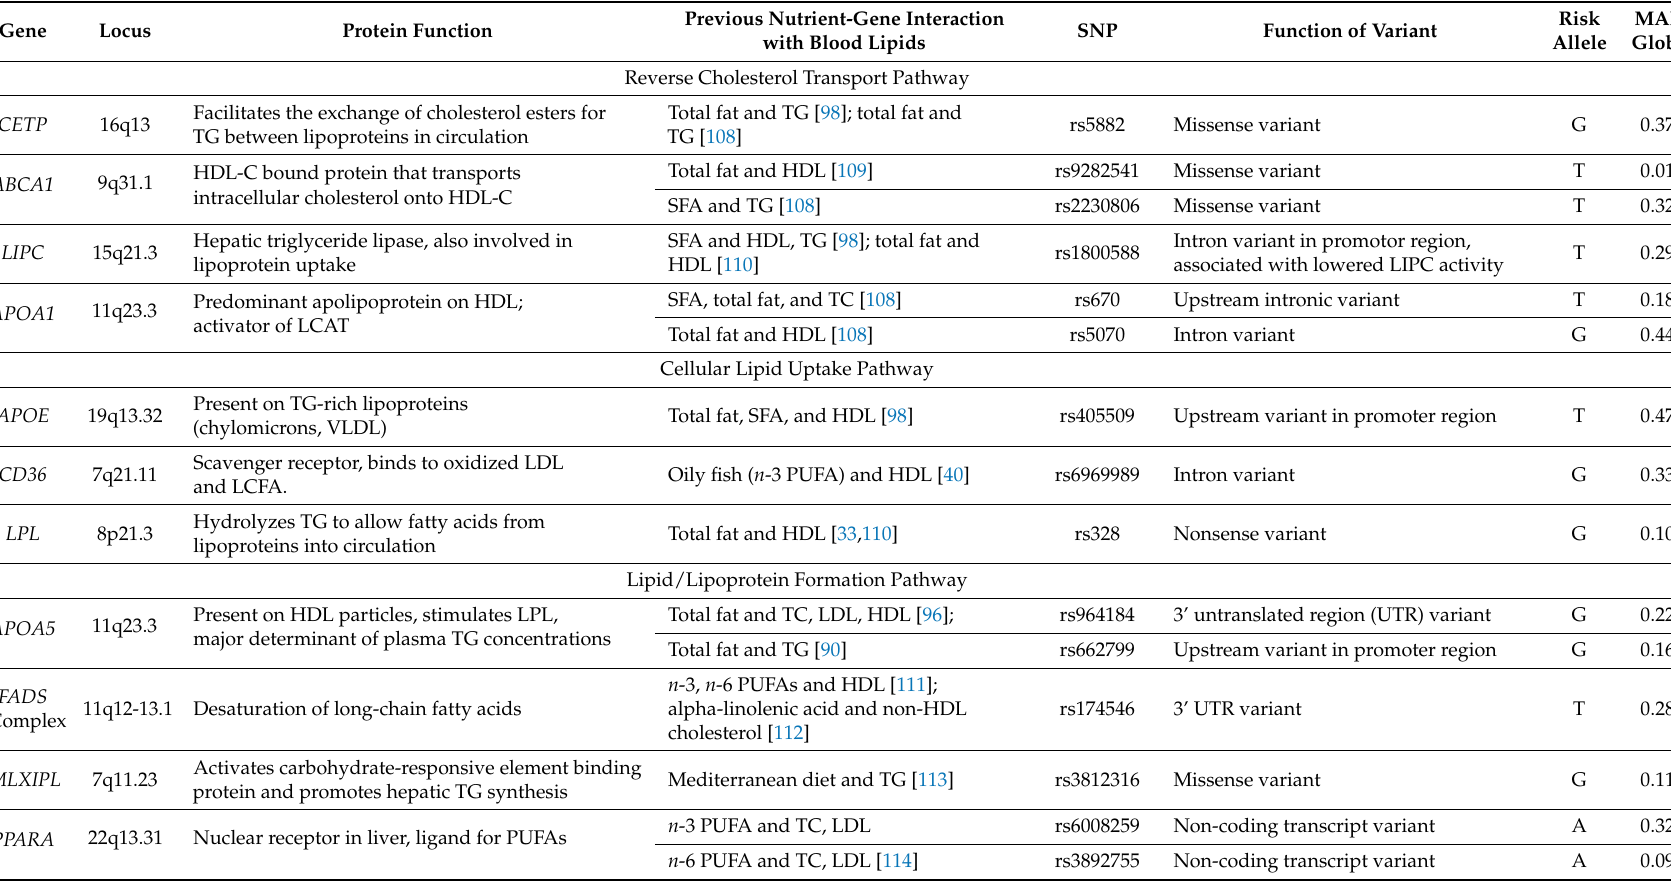
Table 2. Summary of gene-diet interactions between physiologically relevant variables of lipid and lipoprotein metabolism and dietary fat intake associated with blood